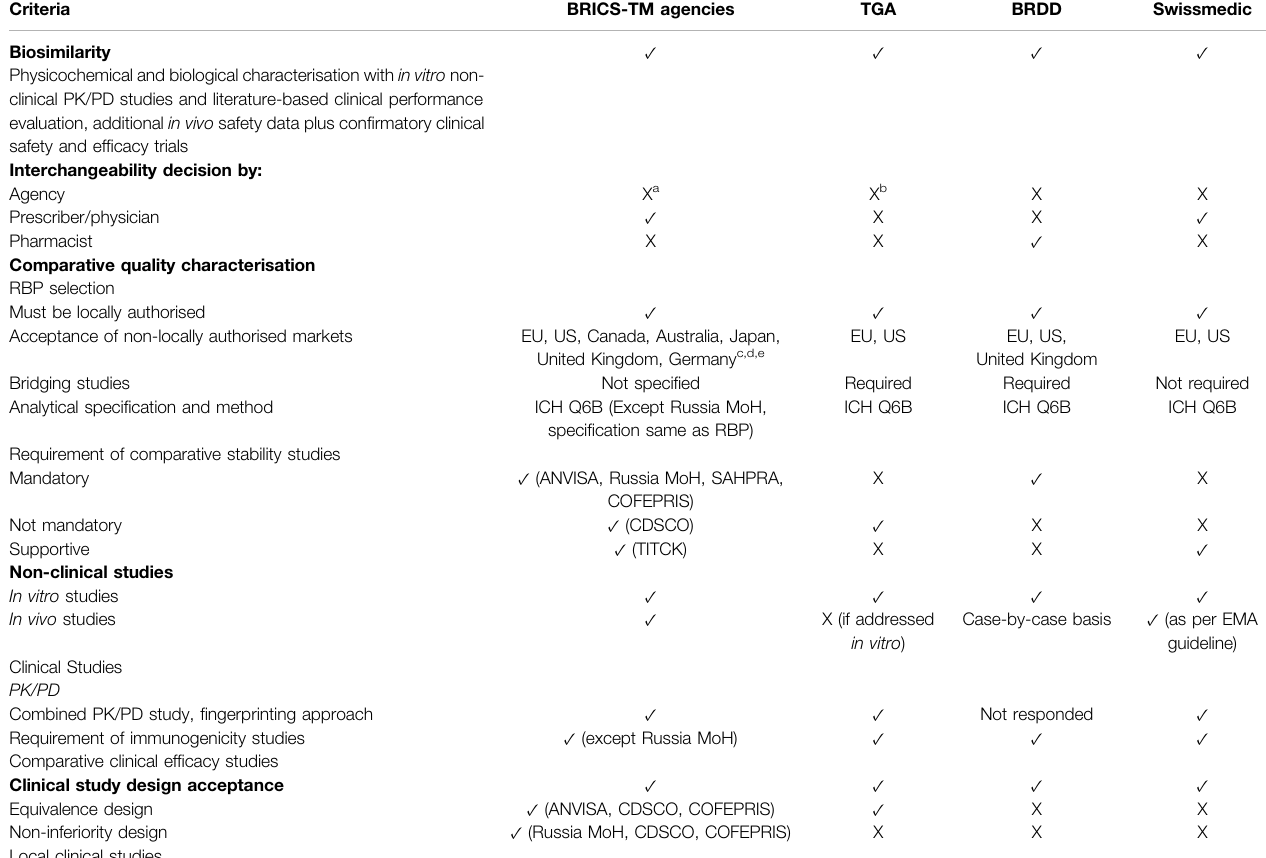
TABLE 2 | Comparison of biosimilar development criteria of BRICS-TM with ACSS